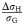
SVEIT vs SVRef for a subject-specific calibration in hypothesis (H2) with the features (a) ΔσH or (b) ΔσH and ΔσHσG.